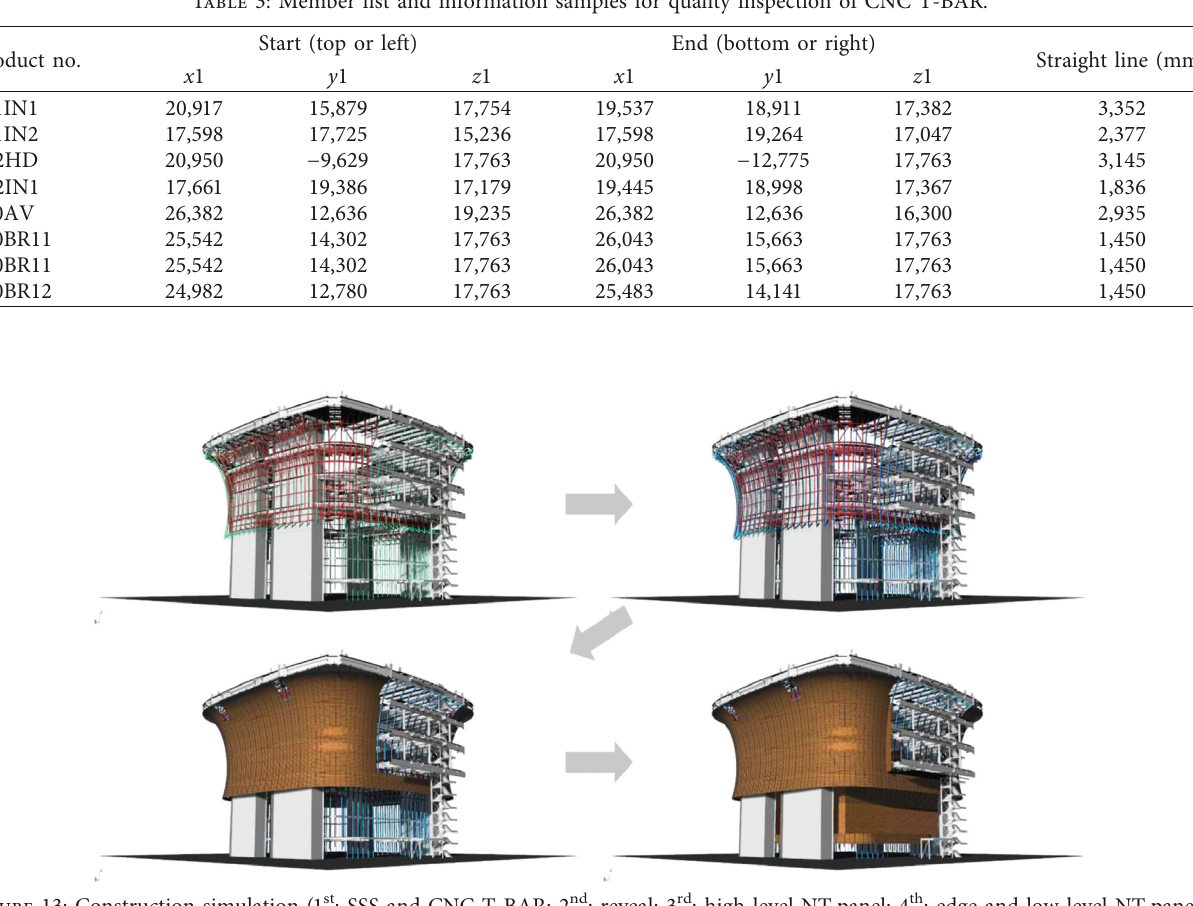
Figure 13: Construction simulation (1 st : SSS and CNC T-BAR; 2 nd : reveal; 3 rd : high-level NT panel; 4 th : edge and low-level NT